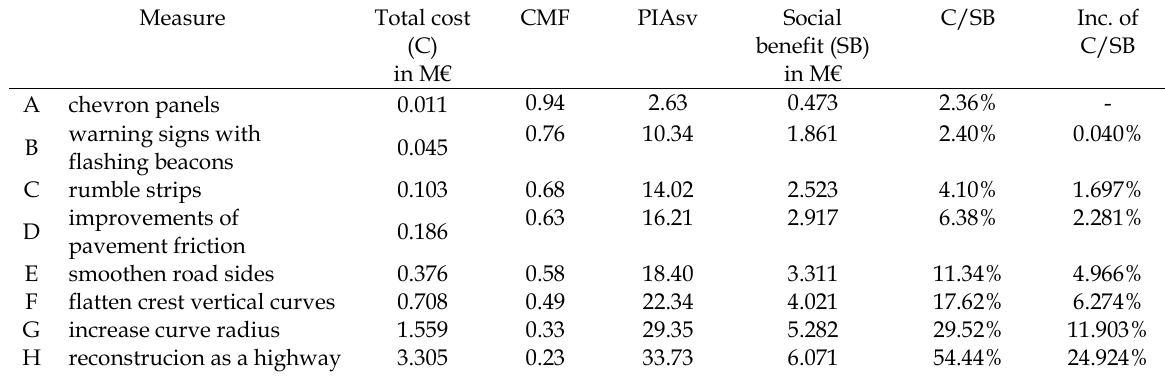
Table 2. Relationship between social benefit and cost of road safety measures for the case of